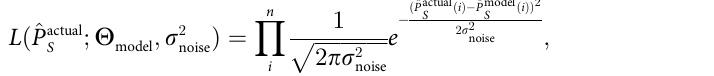
S1 Fig. Experiment 1: RT data. Here, we plot the dynamics of mean RT (across subjects) over the course of the experiment (pre-fMRI session and fMRI session) separately for each reward